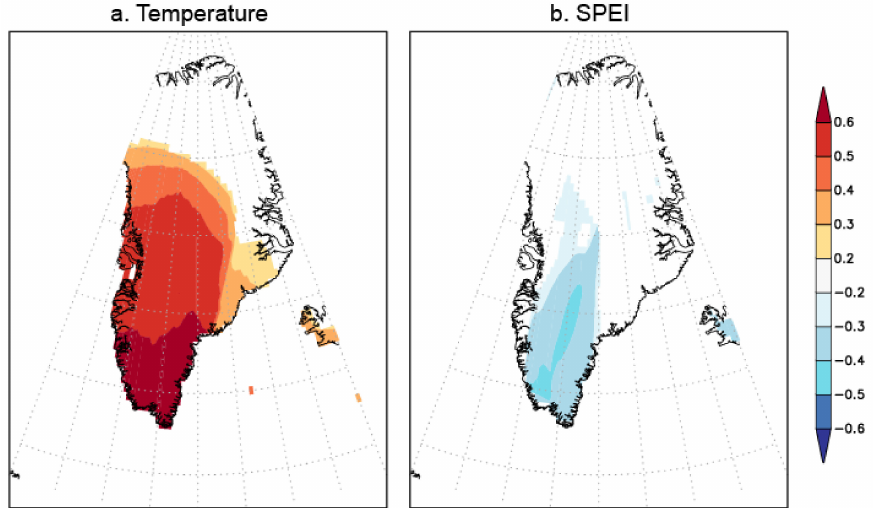
Figure 5. Spatial correlations between tree ring δ 18 O with January–August air temperature ( a ) and June-August SPEI ( b ) for the period of 1950–1999. Correlations not significant at the 95% level have been masked